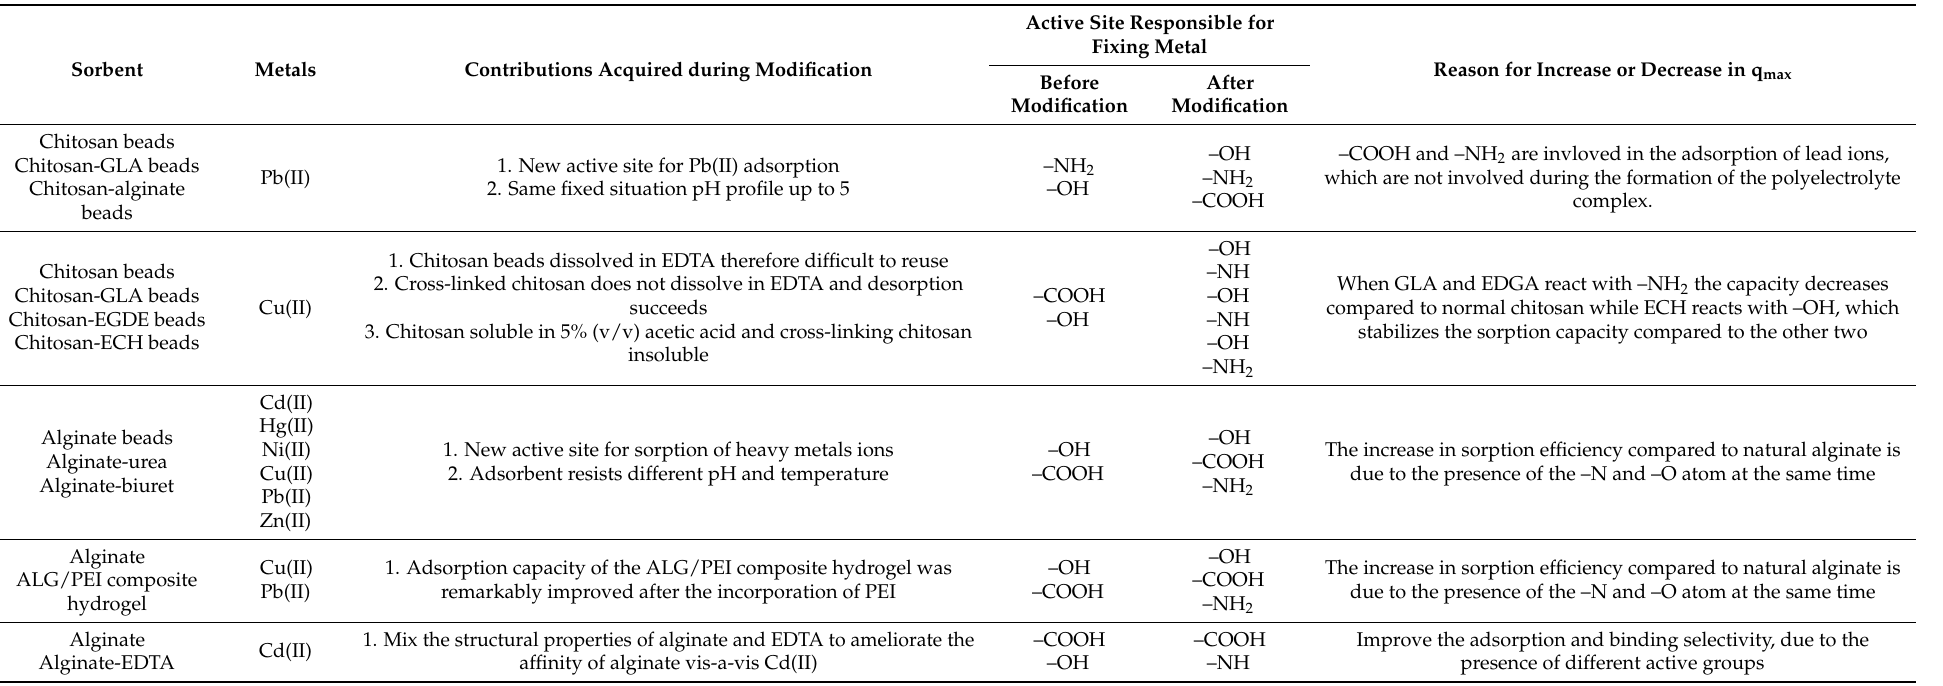
Table A1. Contributions acquired during modification of chitosan and alginate in recent